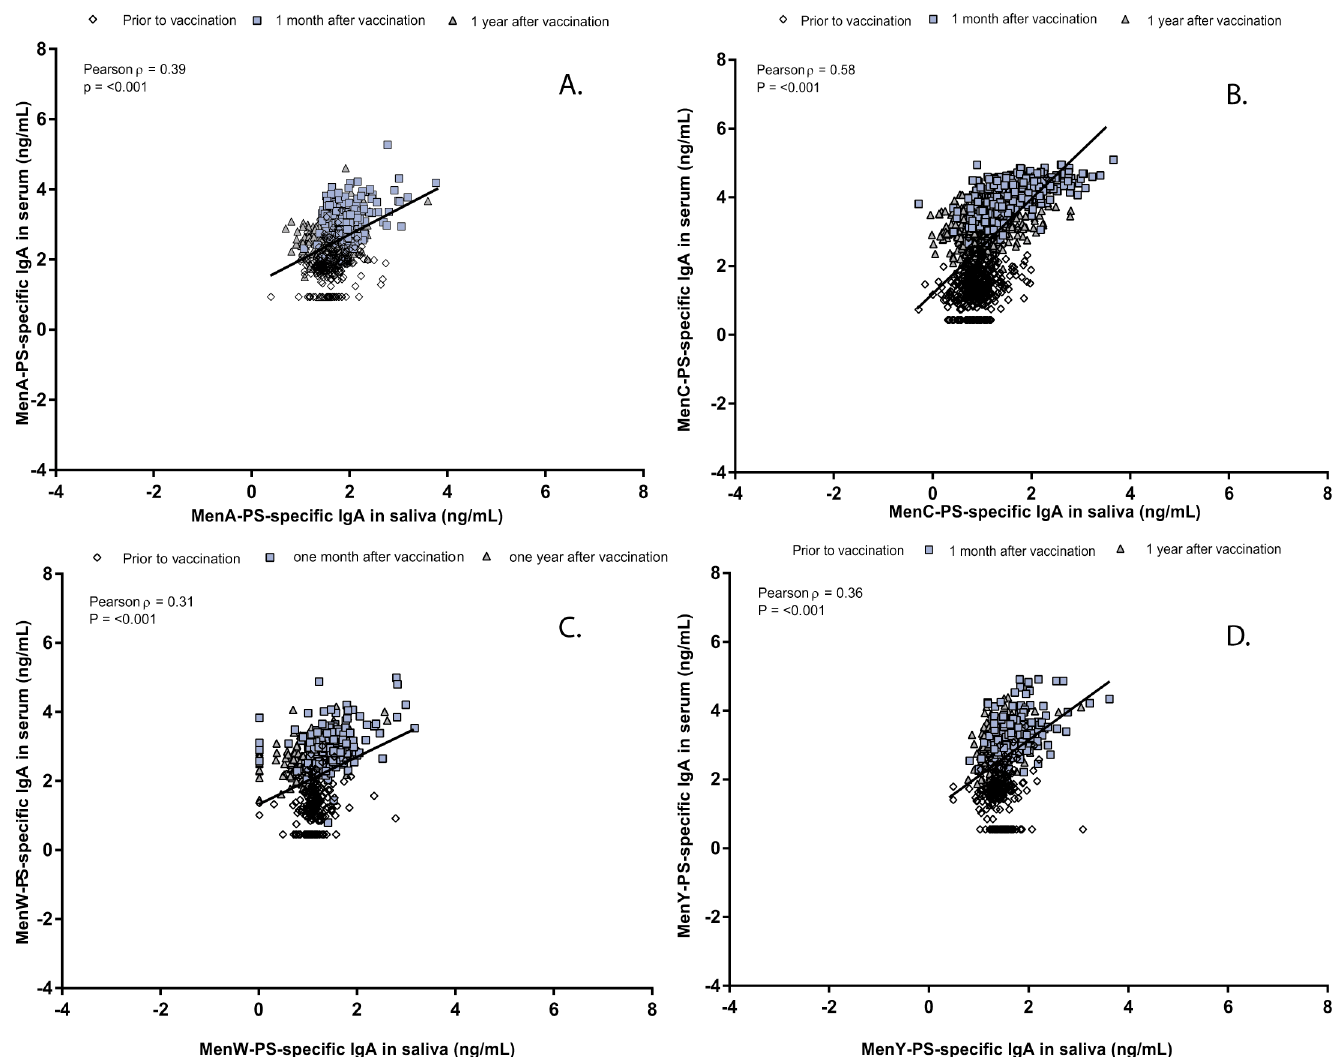
Fig 1. Correlation between log-transformed Immunoglobulin A (IgA) levels in saliva and serum for meningococcal serogroup A (A), C (B), W (C), and Y (D).